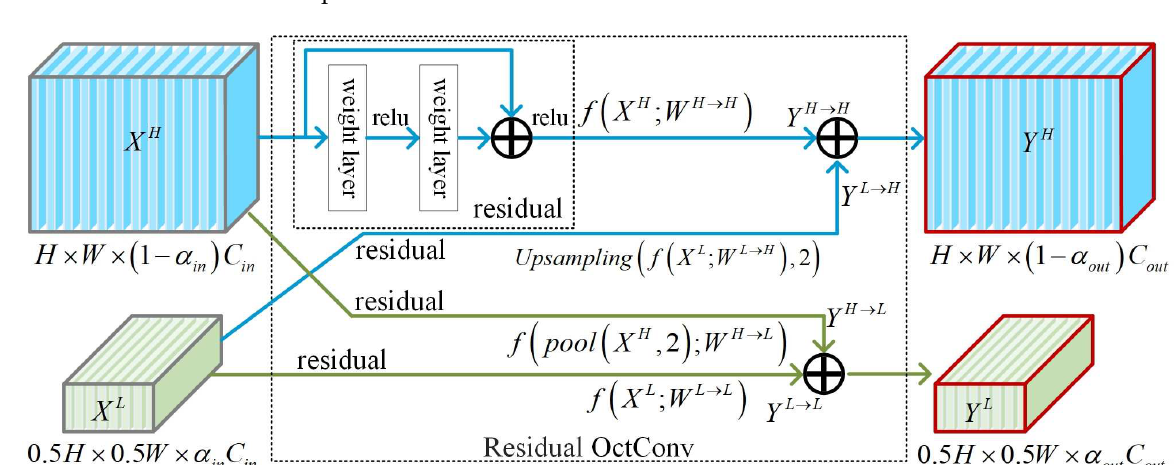
Figure 2. Residual OctConv performs feature map extraction and information communication in dual frequency (high frequency and low frequency). In the entire network framework, the first and last convolutions of the network are set to α in = 0, α out = α and α in = α , α out = 0. The other convolutional layers are set to α in = α out = α . The ratio of high-frequency components to low-frequency components is set to 1 : 1, so the value of α is 0.5. The feature map size of the low-frequency components is set to half the feature map size of the high-frequency components, so its size is 0.5 H × 0.5 W